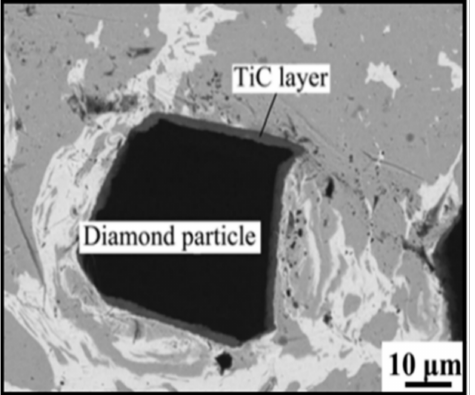
Figure 11. Microstructures of TiC compounds layer. Reprinted with permission from Ref. [57]. Copyright 2013,